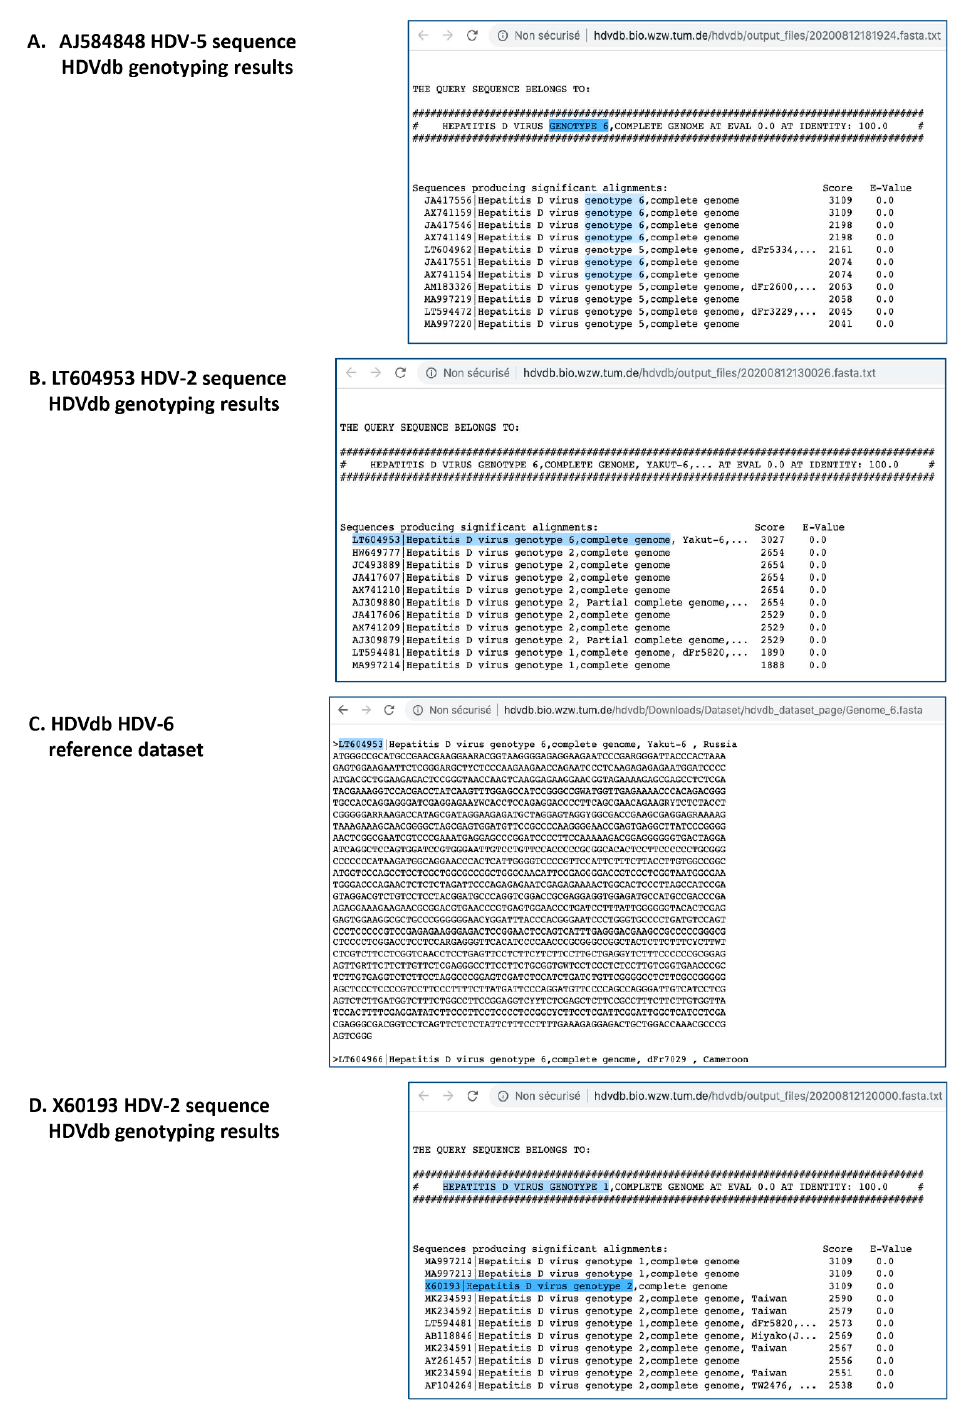
Figure 1. Screenshot of 4 di ff erent pages of HDVdb website. ( A ) HDV-5 ICTV reference sequence (AJ584848) genotyping output detailed results leading to HDV-6 query genotype. ( B ) HDV-2 sequence (LT604953) genotyping output detailed results leading to HDV-6 query genotype. ( C ) HDVdb